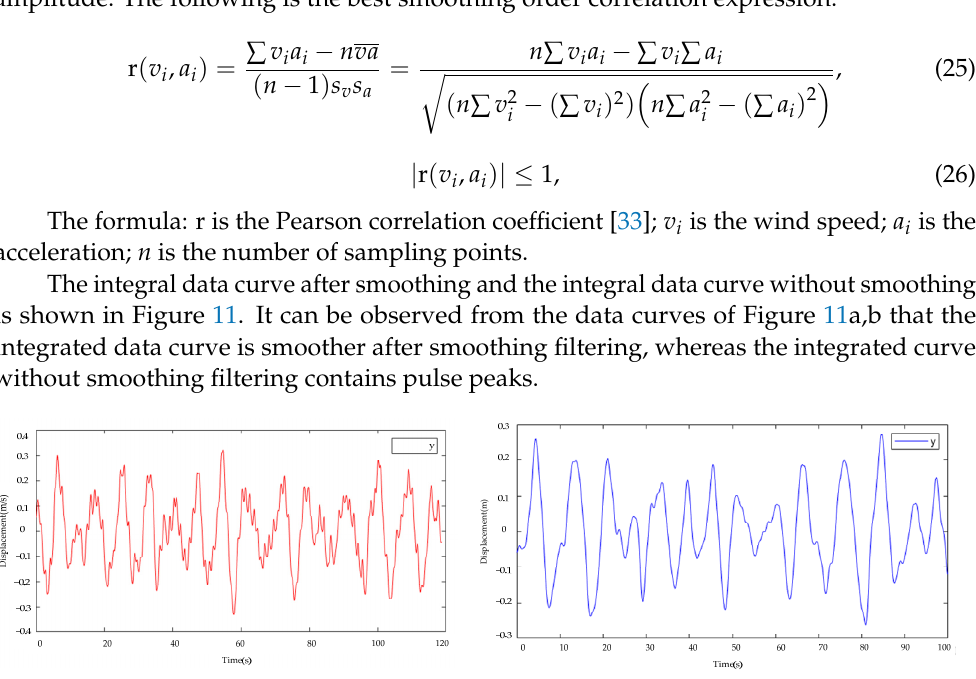
( b ) Figure 12. Different integration techniques’ data curves. ( a ) Double Integral Curve in Time Domain; ( b ) Time-frequency domain hybrid integration curve. 4. Analysis of the Wire Galloping Experiment 4.1. Wire Galloping Experiment Setup The conductor galloping experiment was conducted on the transmission line gallop- ing test bench provided by the State Grid Transmission Line Galloping Prevention and Control Laboratory. The experimental platform serves as a base for assessing if any gal- loping monitoring system is accurate. The wire galloping is produced by the mechanical